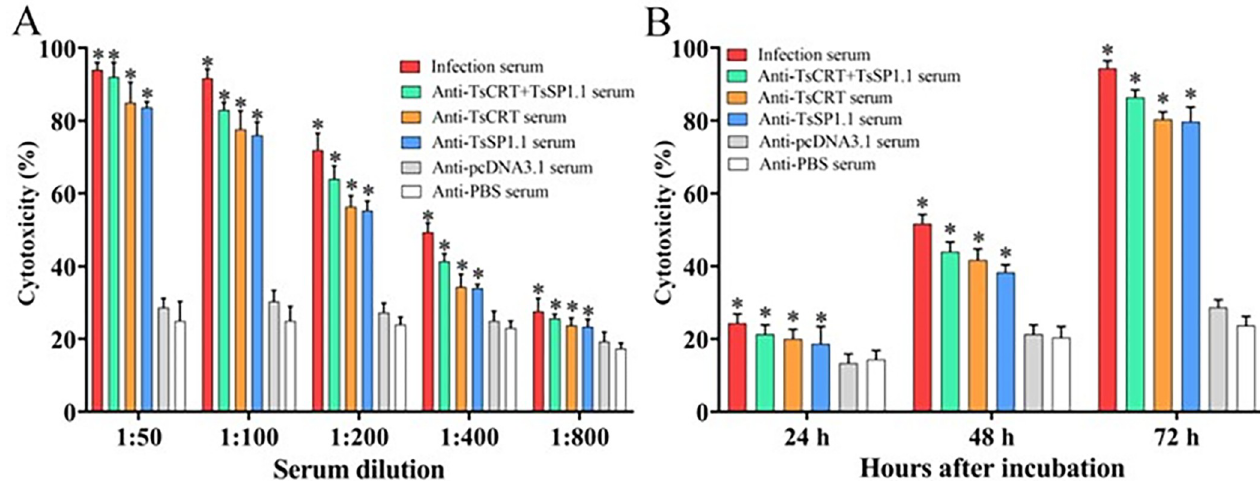
Fig 11. Killing effects of ADCC on the NBL. A: The cytotoxicity was dose-dependent of specific antibodies against TsCRT+TsSP1.1, TsCRT and TsSP1.1. B: The cytotoxicity had an elevating trend with prolongation of culture time. � P < 0.001 relative to sera from the PBS group.